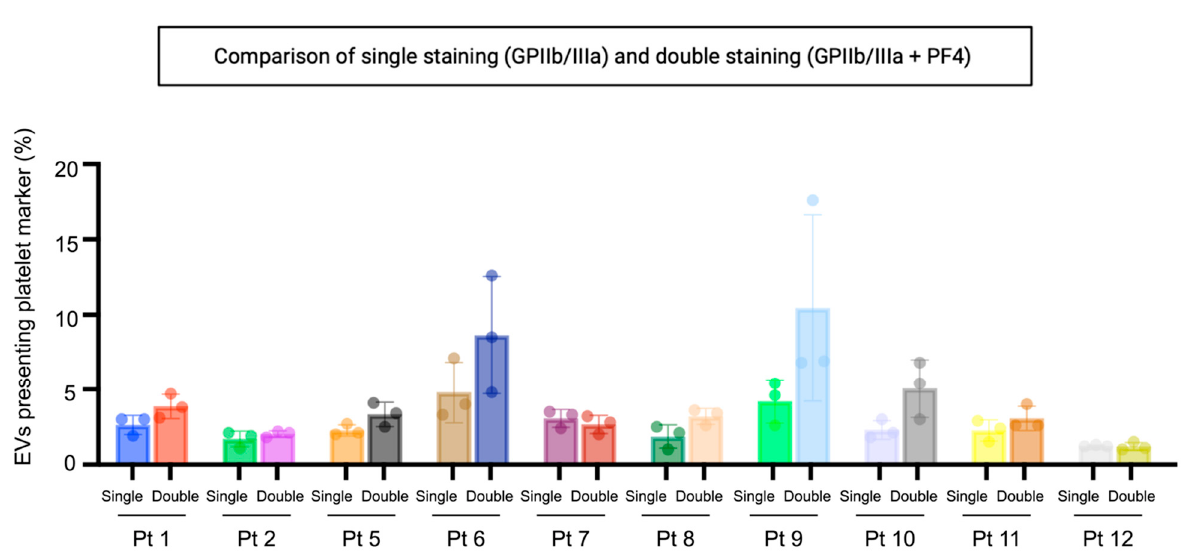
Figure 2. Percentage of particles positive for GPIIb/IIIa and PF4 relative to total EVs. Double labelling will identify EVs with one or both platelet markers. Samples were fluorescently labelled with FITC-conjugated antibodies specific to GPIIb/IIIa and PF4. EVs were determined as >45 nm diameter particles positive for CellMask™ deep red plasma membrane labelling. Single: single staining for GPIIa/IIIb. Double: double staining for GPIIb/IIIa and PF4. Pt: patient.